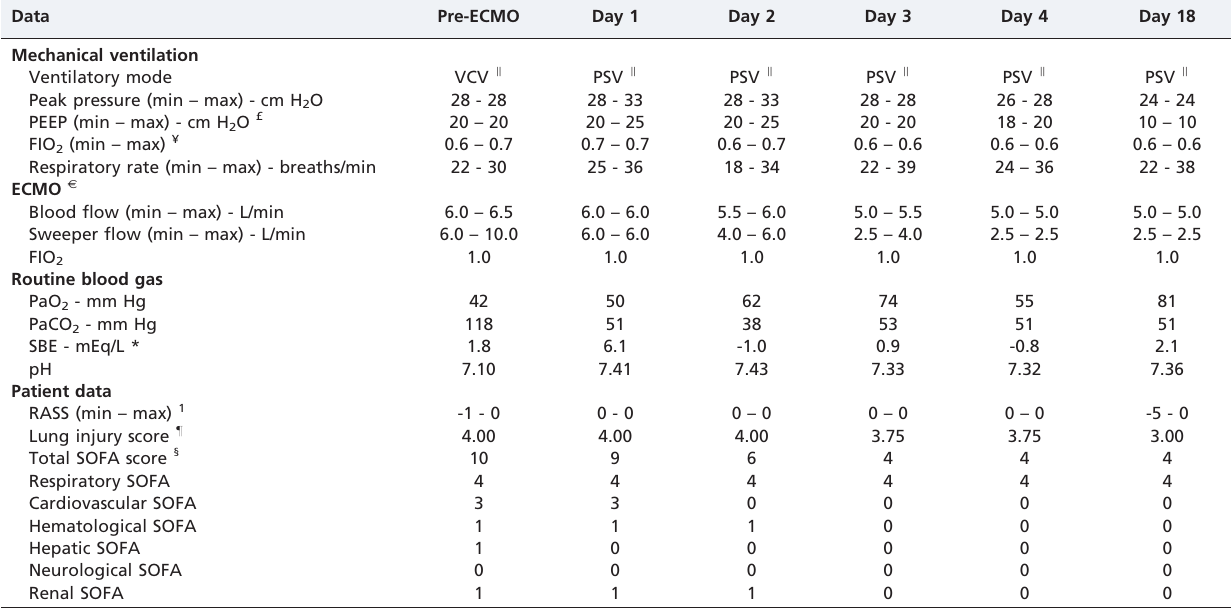
Table 1 - Clinical data and arterial blood gases.